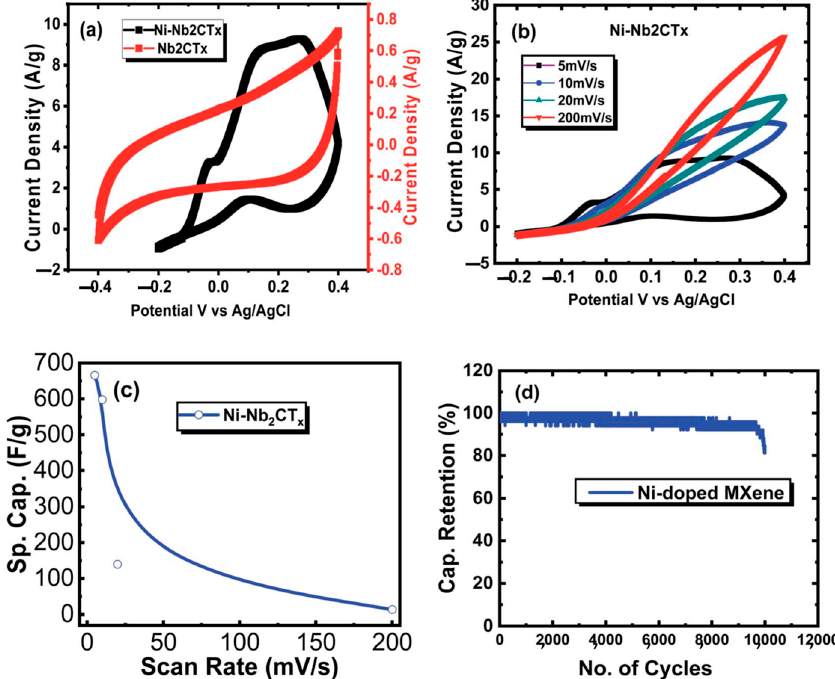
Figure 6. ( a ) Cyclic voltammogram (CV) curves for Nb 2 CT x and Ni–Nb 2 CT x in 1 M PVA–H 2 SO 4 at 5 mV/s. ( b ) CV curves explicitly for Ni–Nb 2 CT x at different scan rates. ( c ) SC vs. scan rate for Ni–Nb 2 CT x . ( d ) Capacitance retention vs. cycle number for Ni–Nb 2 CT x . Reprinted with permission from Ref. [74].